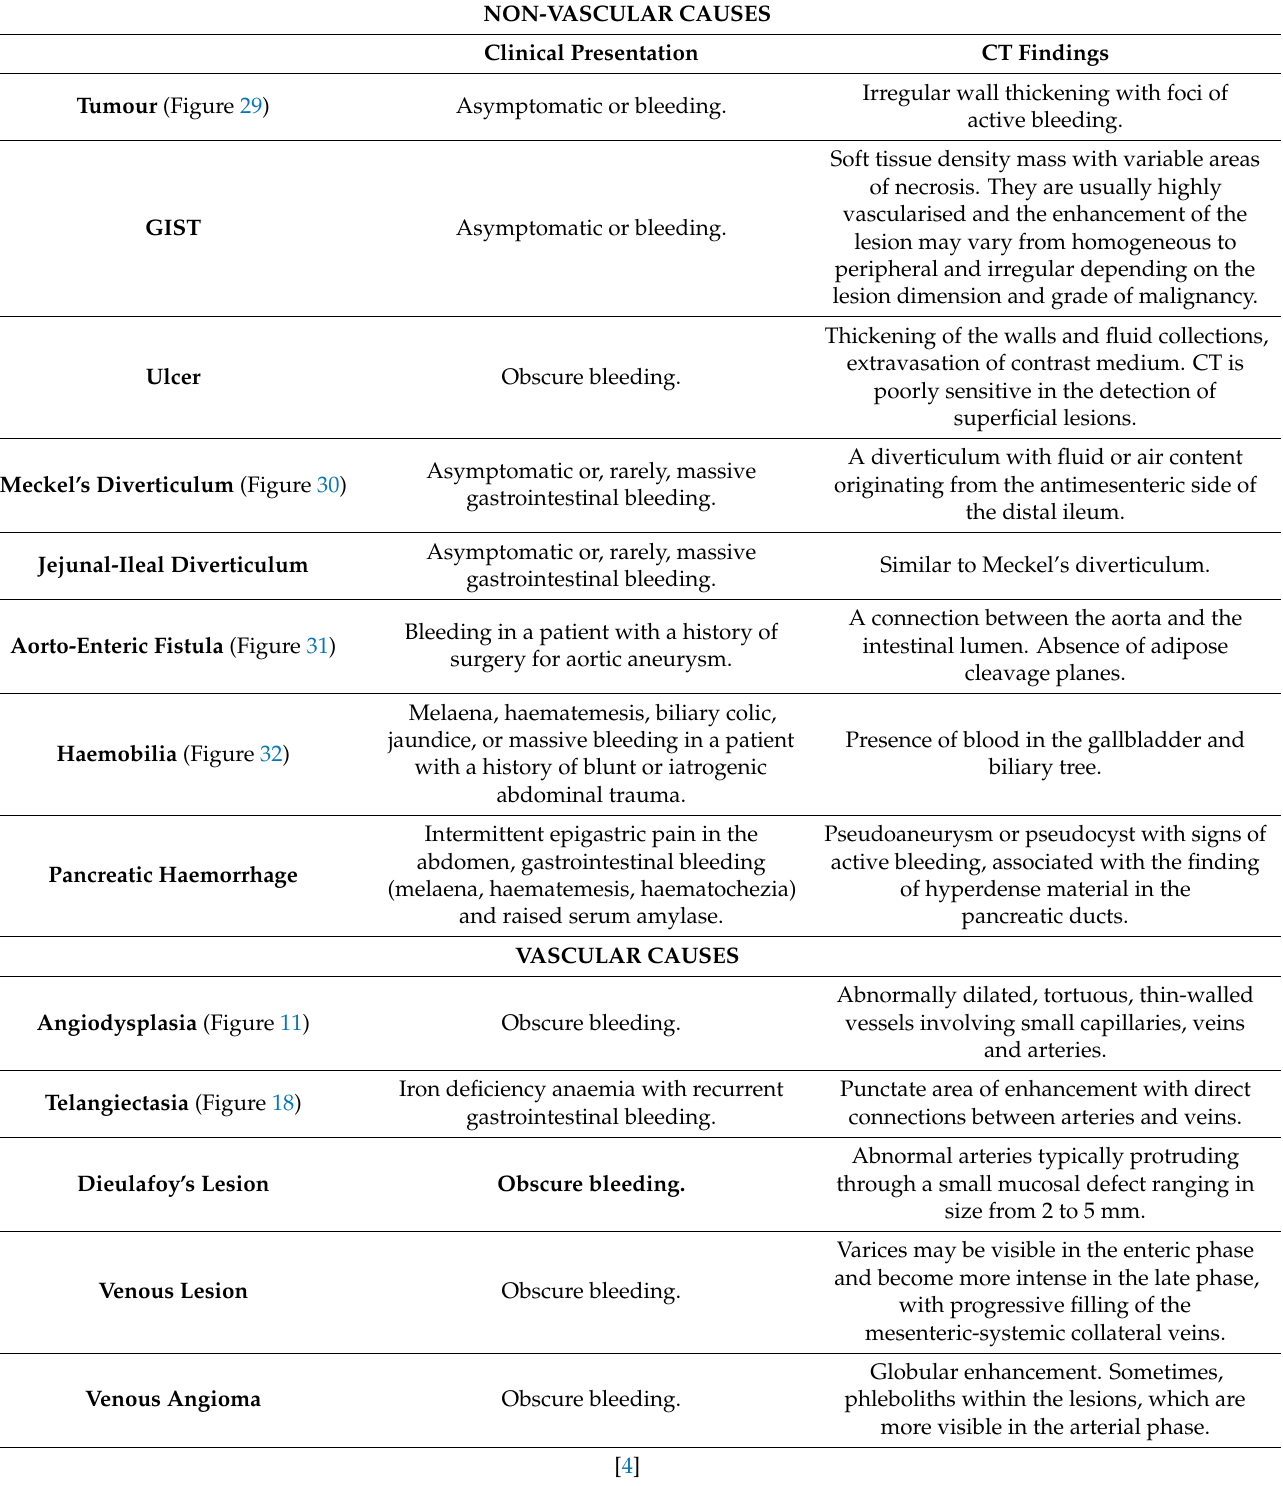
Table 6. Frequent vascular and non-vascular causes of SBB/MGIB: clinical presentation and CT